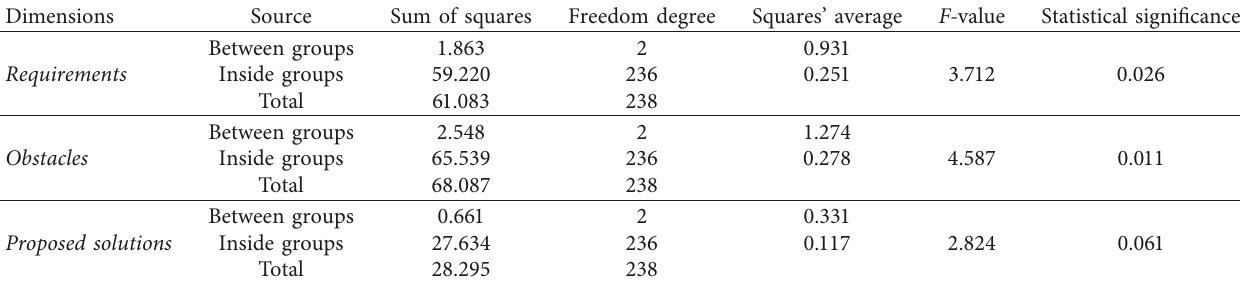
Table 14: Experience impacts requirements and problems and offered ways to overcome obstacles of distance education in the face of university educational crises.